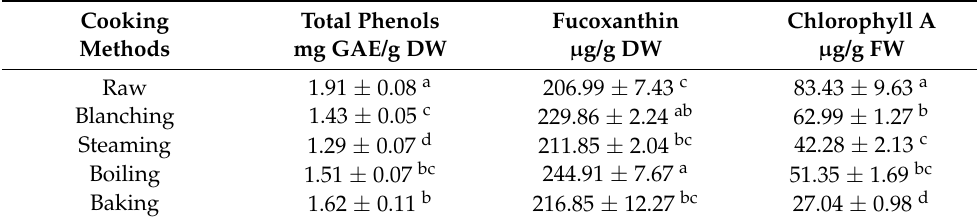
Table 3. Effects of different cooking methods on the contents of total phenols, fucoxanthin and chlorophyll A in U. pinnatifida